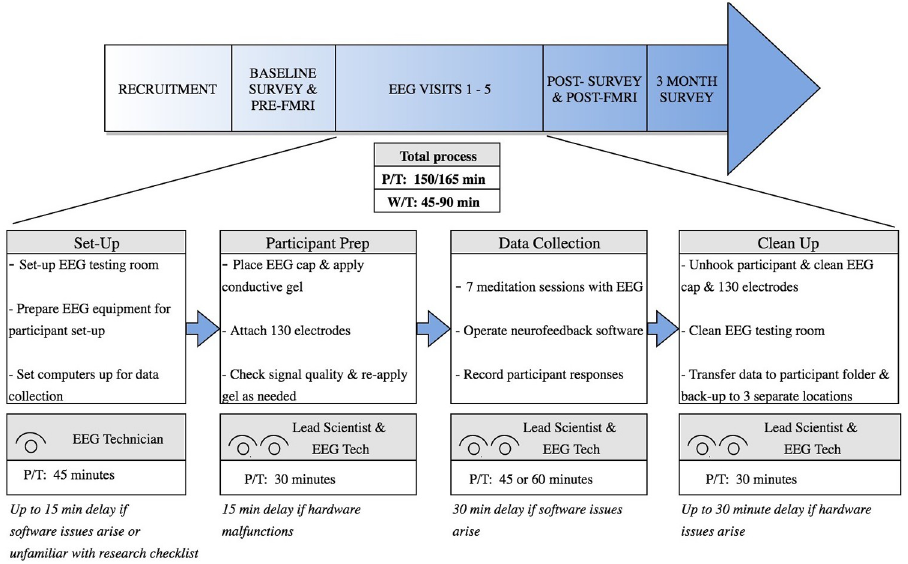
Fig 1. Value stream map depicting workflow of neurofeedback session (P/T: Process time, W/T: Wait time). fMRI: Functional magnetic resonance imaging. EEG: Electroencephalography.